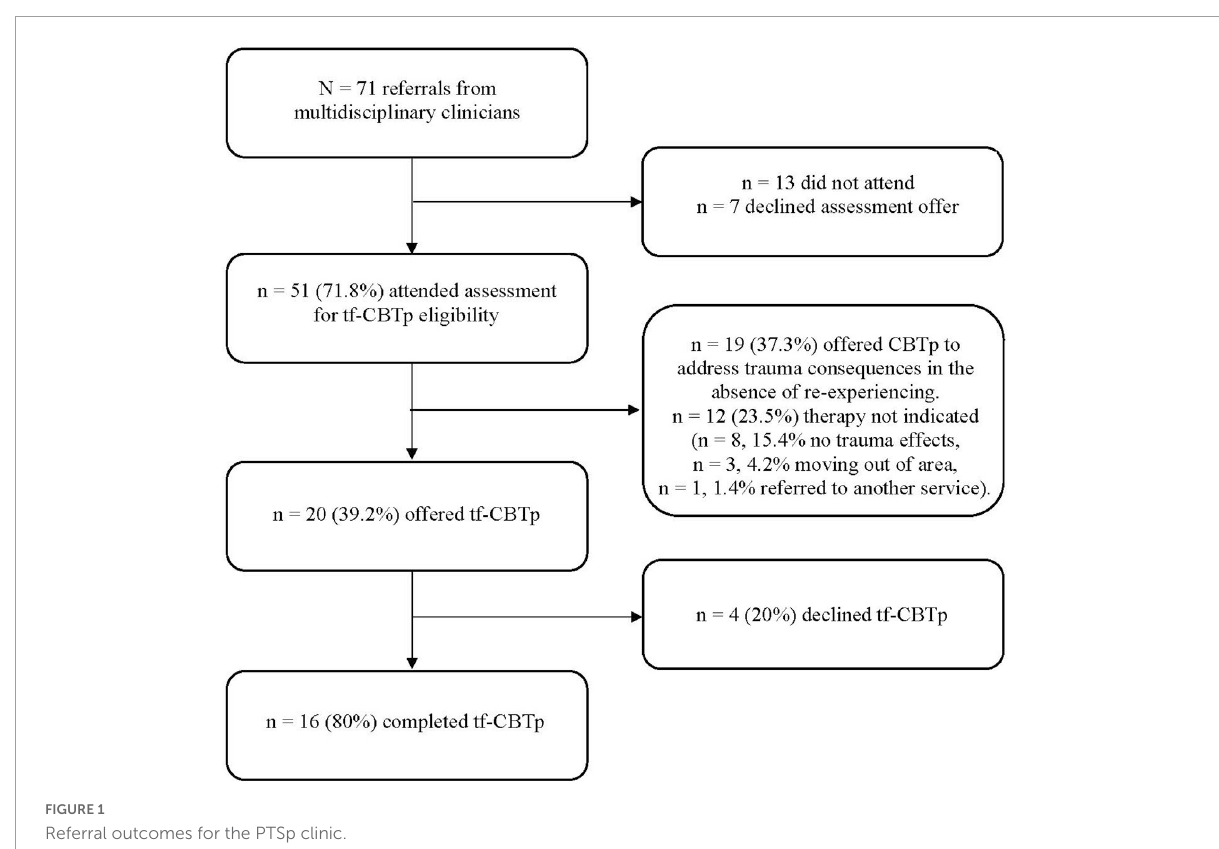
FIGURE1 Referral outcomes for the PTSp clinic.